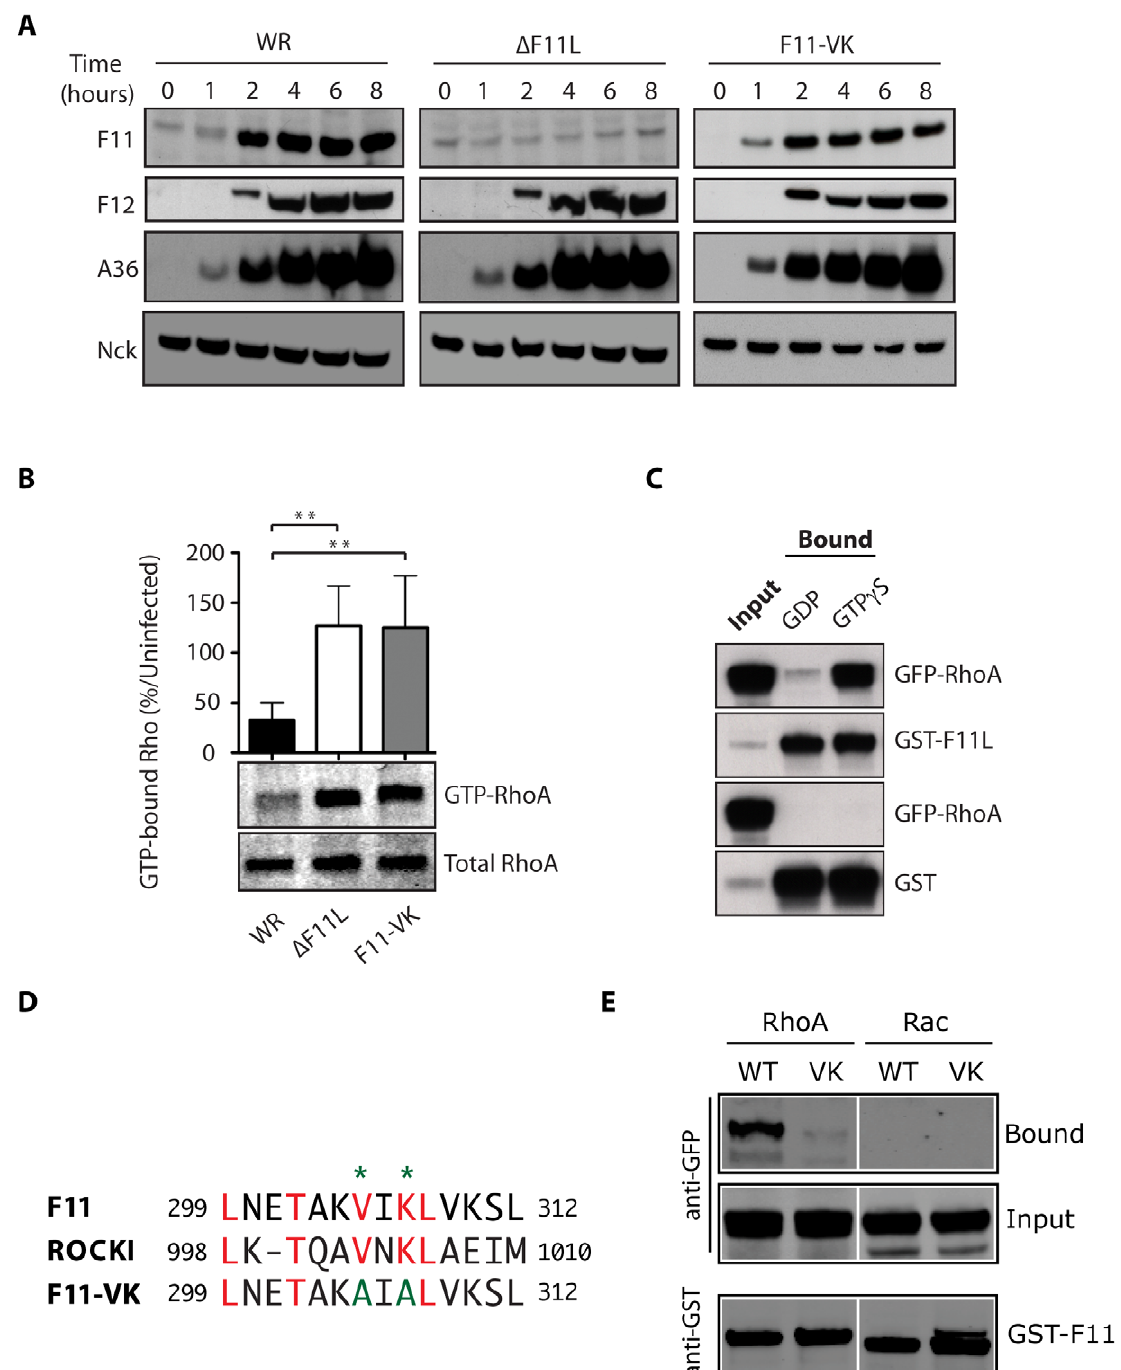
Figure 2. F11 binds GTP-bound RhoA to inhibit its signalling during infection. ( A ) Immunoblot analysis reveals that F11 is detected as early as 2 hours post infection in WR and F11-VK but not D F11L infected cells. The kinetics of A36 and F12 expression are unaffected by the loss of F11 and Nck represents a loading control. ( B ) Quantitative immunoblot analysis of Rho activation Rhotekin pull down assays reveals that WR but not D F11L or F11-VK reduces the level of GTP-bound RhoA at 8 hours post infection as compared to non-infected controls. A representative immunoblot of the level of GTP-bound and total RhoA is shown. Error bars represent standard error of the mean (SEM) from 4 independent experiments and *=P , 0.05. ( C ) Immunoblot analysis of glutathione resin pull down assays from vaccinia virus infected cell extracts, reveals that GST-tagged F11 interacts with GTP c S (GTP) but not GDP bound RhoA. ( D ) Sequence alignment of F11 and the RhoA binding motif in ROCK1. Identical residues are shown in red and the positions of valine 305 and lysine 307 in F11 that are mutated to alanine in the F11-VK mutant are indicated. ( E ) Immunoblot analysis of glutathione resin pull down assays reveals that GST-tagged F11 but not F11-VK interacts with GFP-RhoA. Neither protein interacts with GFP-Rac. ( D ).